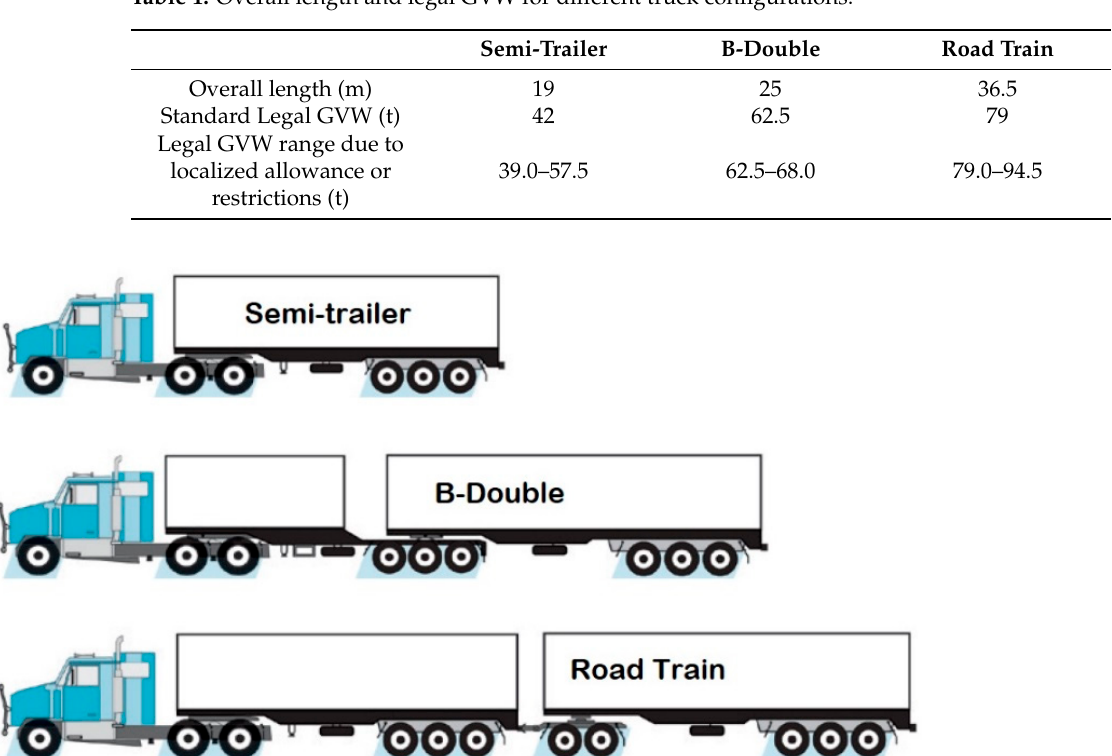
Table 1 . Overall length and legal GVW for different truck configurations . Table 1. Overall length and legal GVW for different truck configurations.